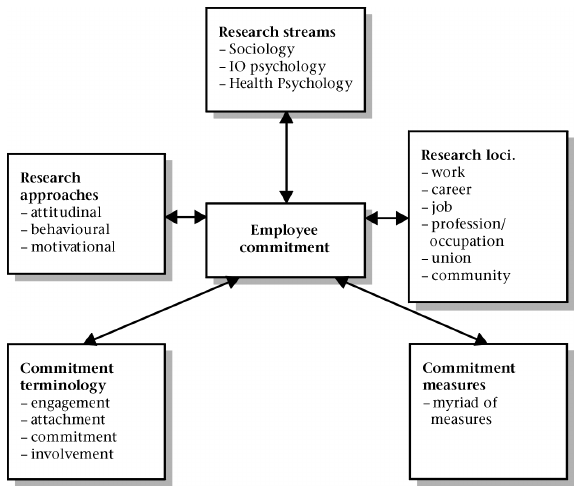
Figure 1: Important domains of commitment